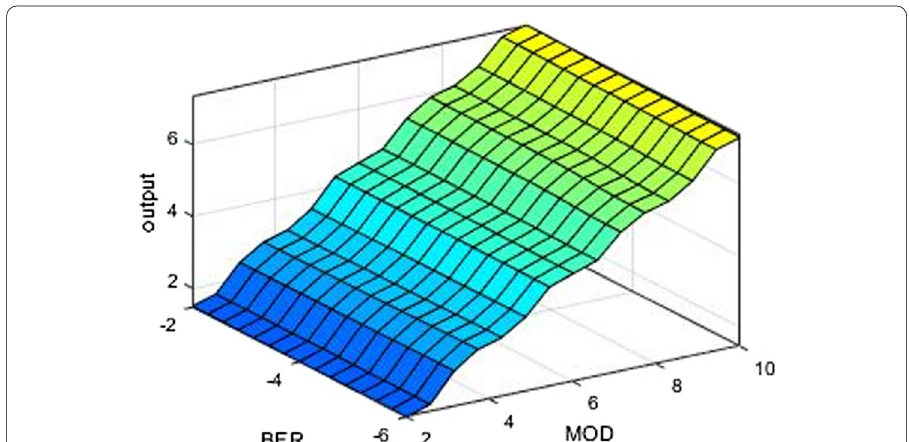
Fig. 22 ANFIS surface view for BER versus MOD. This figure shows the 3D ANFIS surface views of the QAM modulation order and BER combination result. The upper yellow surface indicates a high order modulation schemes in achieving the indicated values of BER. The surface with blue color indicates a low data rate resulted from a low order modulation schemes for various target BER